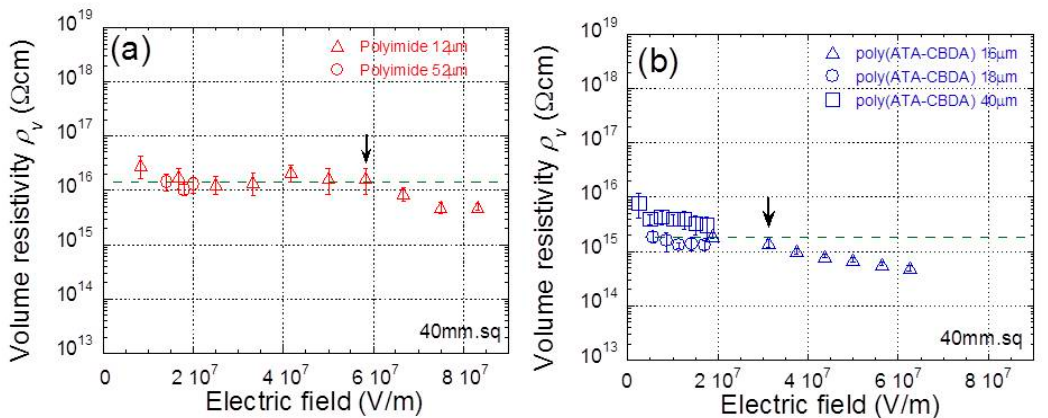
Figure 5. Relation between electric resistivity at 1000 V and thickness for polyimide and biopolyimide films.